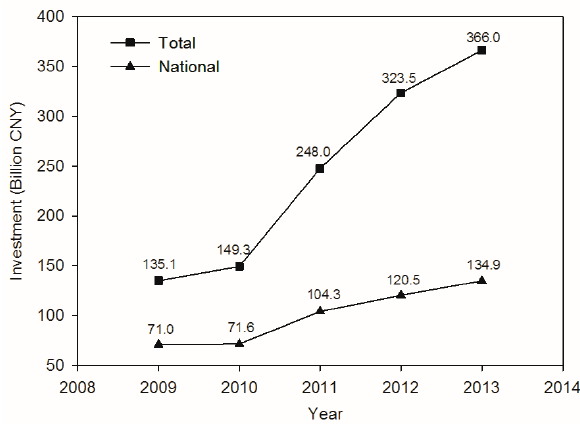
Figure 2. Investment in the forestry sector. Source: China Forestry Statistical Yearbook (2009–2013) [17].